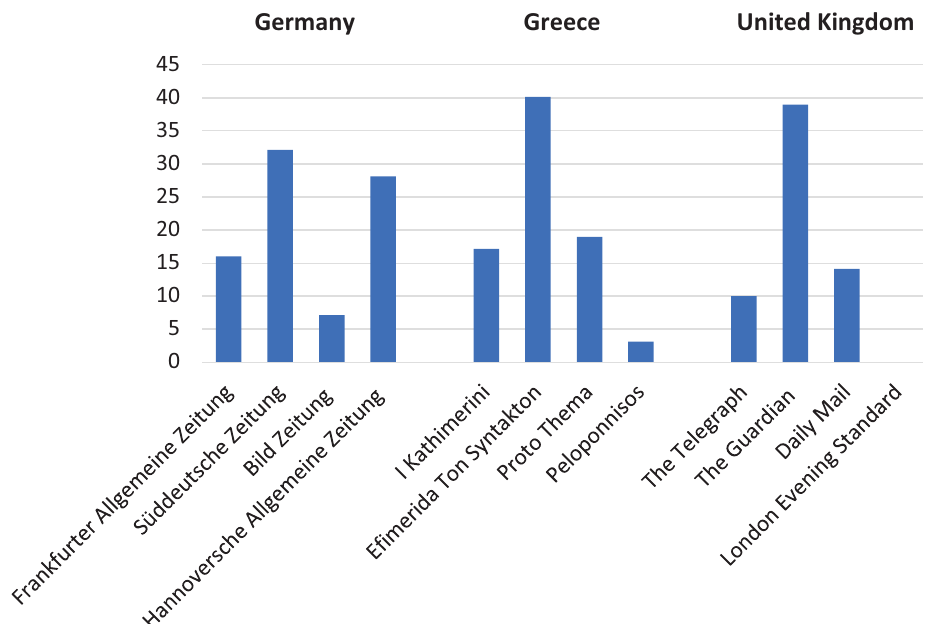
Figure 2. Coverage on the refugee issue and